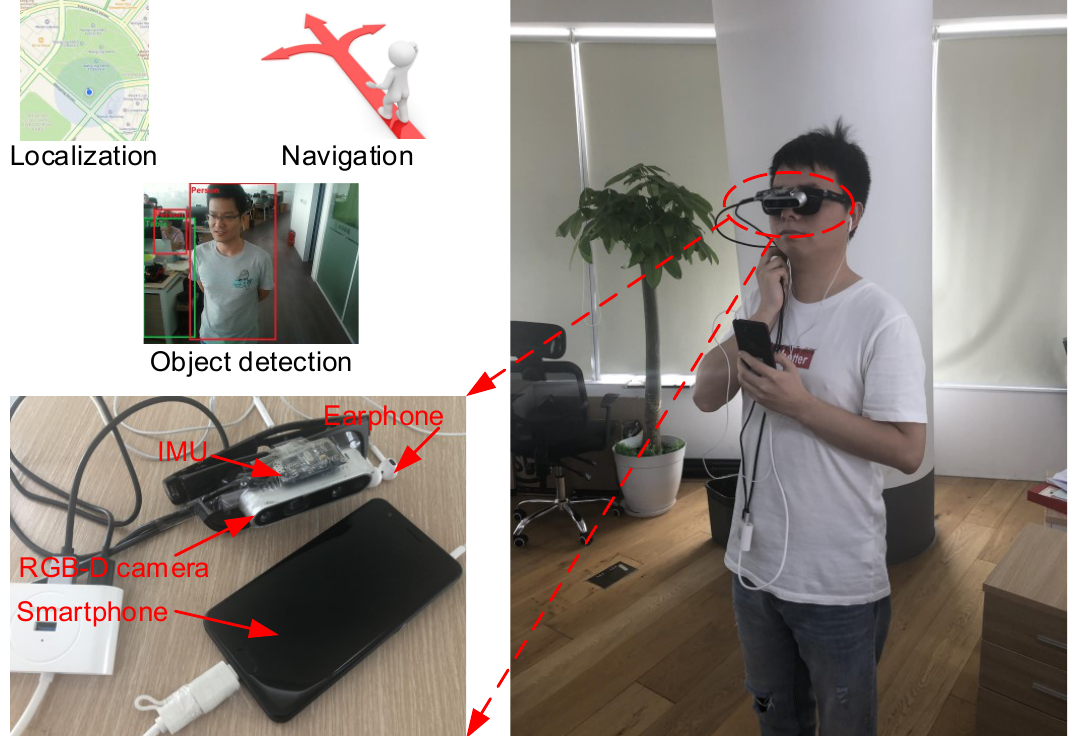
Figure 1. The prototype of the proposed wearable assistive